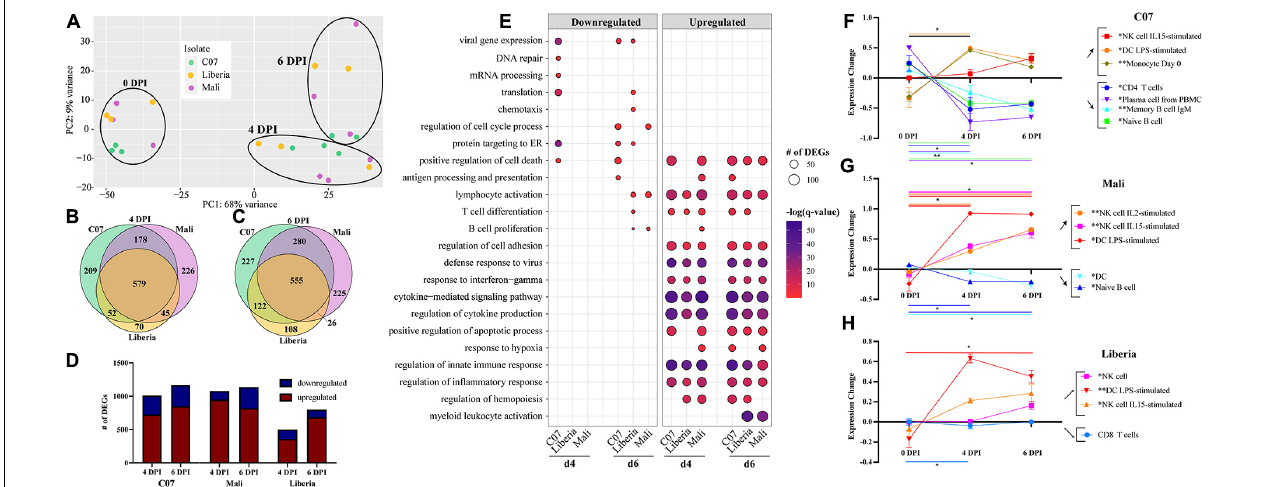
FIGURE 3 | Host response comparison between early and late isolates of EBOV-Makona. (A) Principal component analysis of normalized transcript counts at 0, 4, and 6 DPI for EBOV-Makona isolates. Venn diagrams of number of differentially expressed genes (DEGs) (FDR 0.05, fold change ≥ 1 or 1, RPKM 5) identified through EdgeR following infection with either EBOV-Makona Guinea C07, Liberia, or Mali at (B) 4 DPI and (C) 6 DPI. (D) Bar graph of DEGs detected at 4 and 6 DPI for each isolate. (E) Bubbleplot presenting functional enrichment of upregulated and downregulated DEGs detected in each isolate at 4 and 6 DPI. The size of the bubble represents the number of DEGs, while the color represents the –log( q -value). ImmQuant analysis using DMAP and IRIS datasets for (F) C07, (G) Mali, and (H) Liberia. Lines are color-coded on the graph to match both the subset listed in the legend and the significance lines, of which both ends denote the two time points of the two-way multiple comparisons significance testing. A “*” over a legend denotes overall significance through the mixed effects model test. * p < 0.05, ** p < 0.01, *** p <